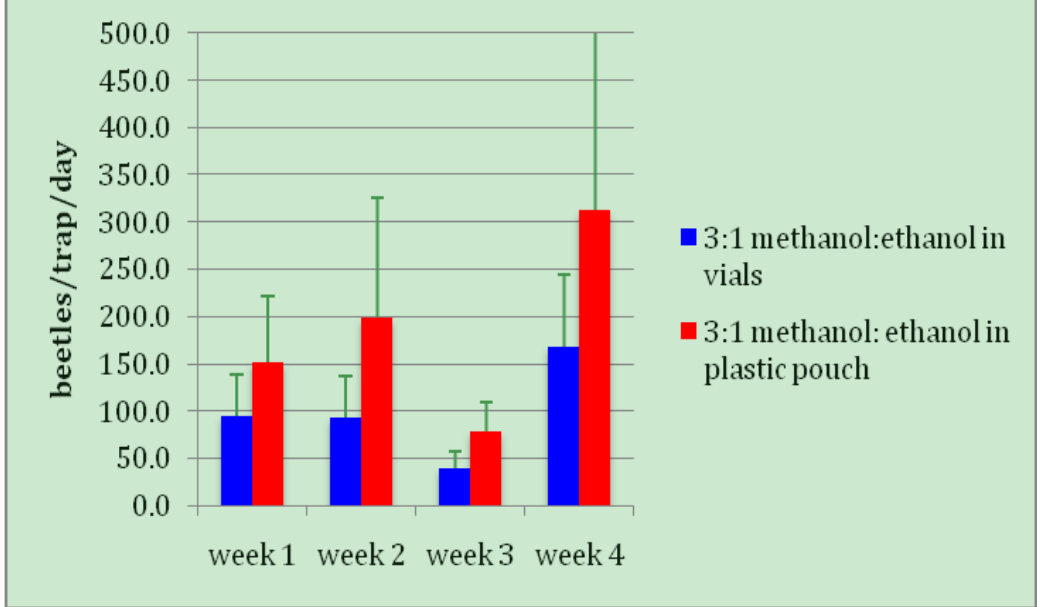
Figure 5. Trap captures of coffee berry borers, using alcohols in vials vs. plastic